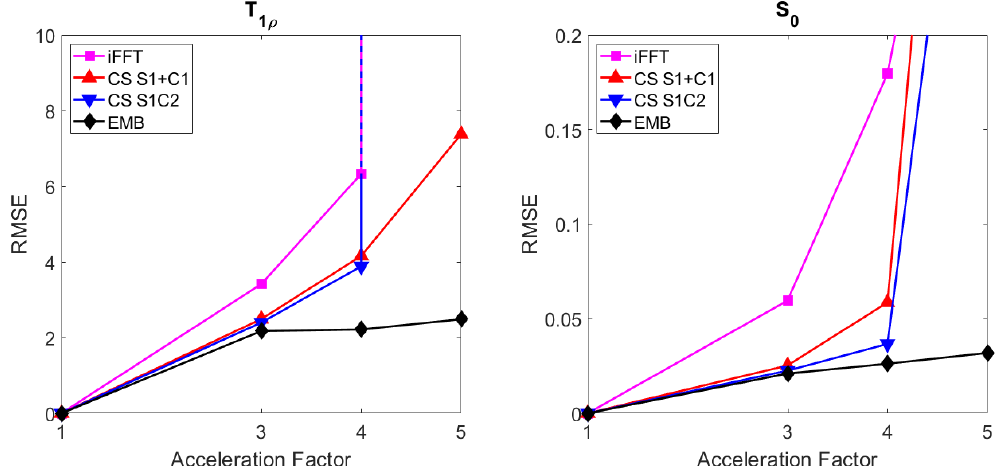
Figure 9. The RMSEs of the T 1 ρ ( left ) and S 0 ( right ) maps of the cartesian ex vivo mouse kidney data with the embedded, CS S1+C1, CS S1C2, and iFFT models at acceleration factors 2, 3, 4, and